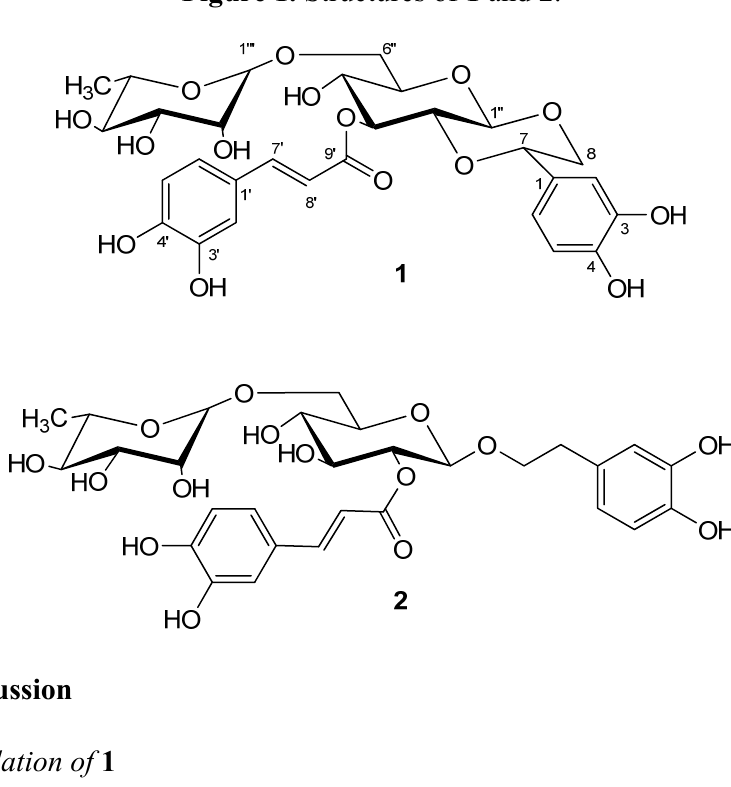
Figure 1. Structures of 1 and 2